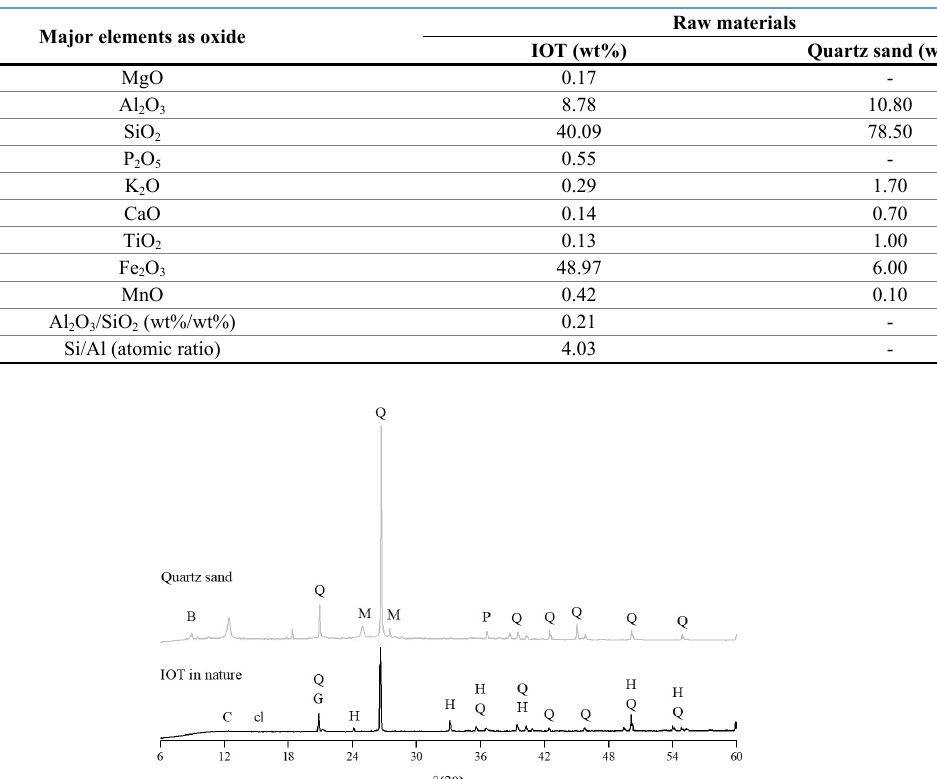
Table 1. Chemical composition of iron ore tailings and quartz sand.